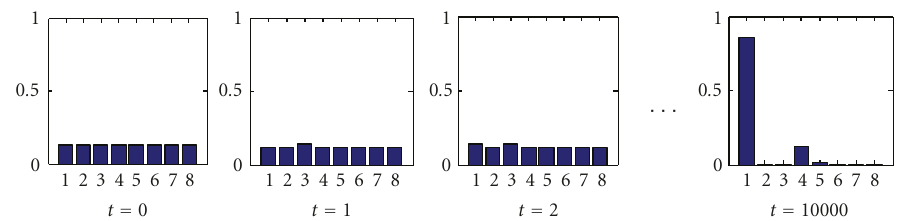
Figure 6: Rule distribution update in SPERO for 8 pure rules (see Section 6).